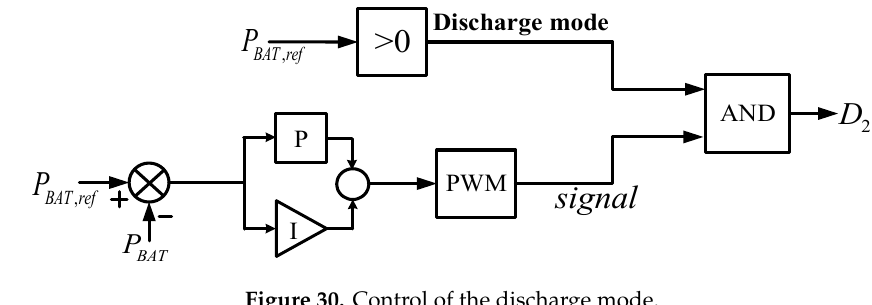
Figure 30. Control of the discharge mode.